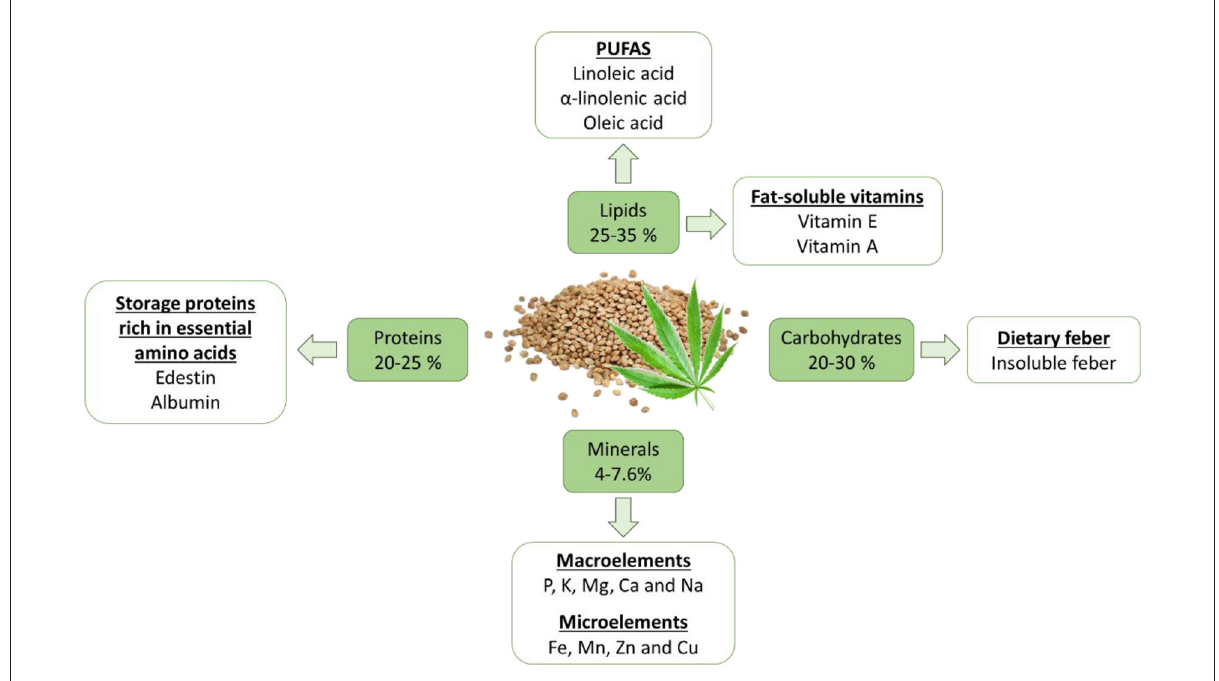
FIGURE3 Macro and micronutrient nutritional value of hemp